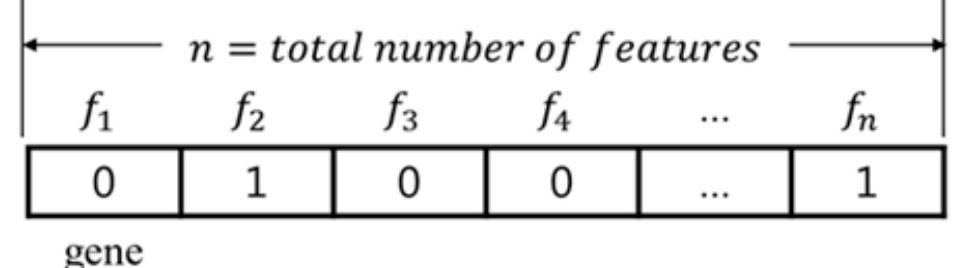
Figure 4. An example of binary decoding.